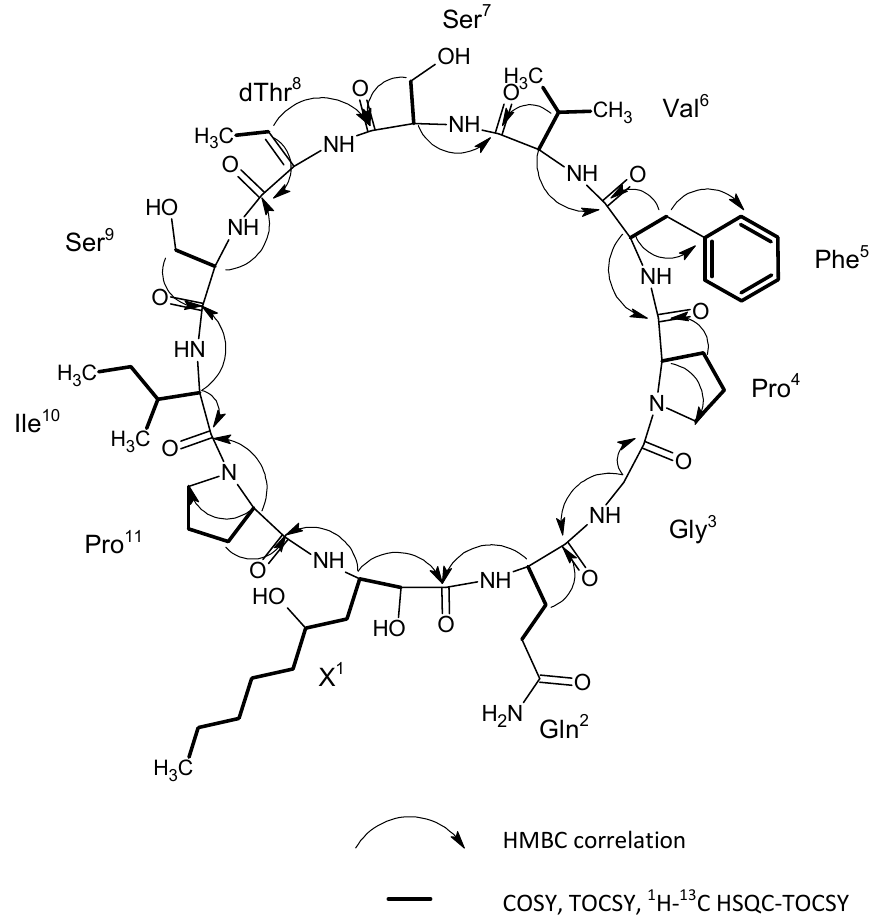
Figure 4. Selected correlations obtained by 2D NMR spectroscopy experiments for compound 1 . Table 2. 1 H and 13 C-NMR data of 1 (600.13 MHz for 1 H, 150.93 MHz for 13 C, CD3OD, 303.2 K).